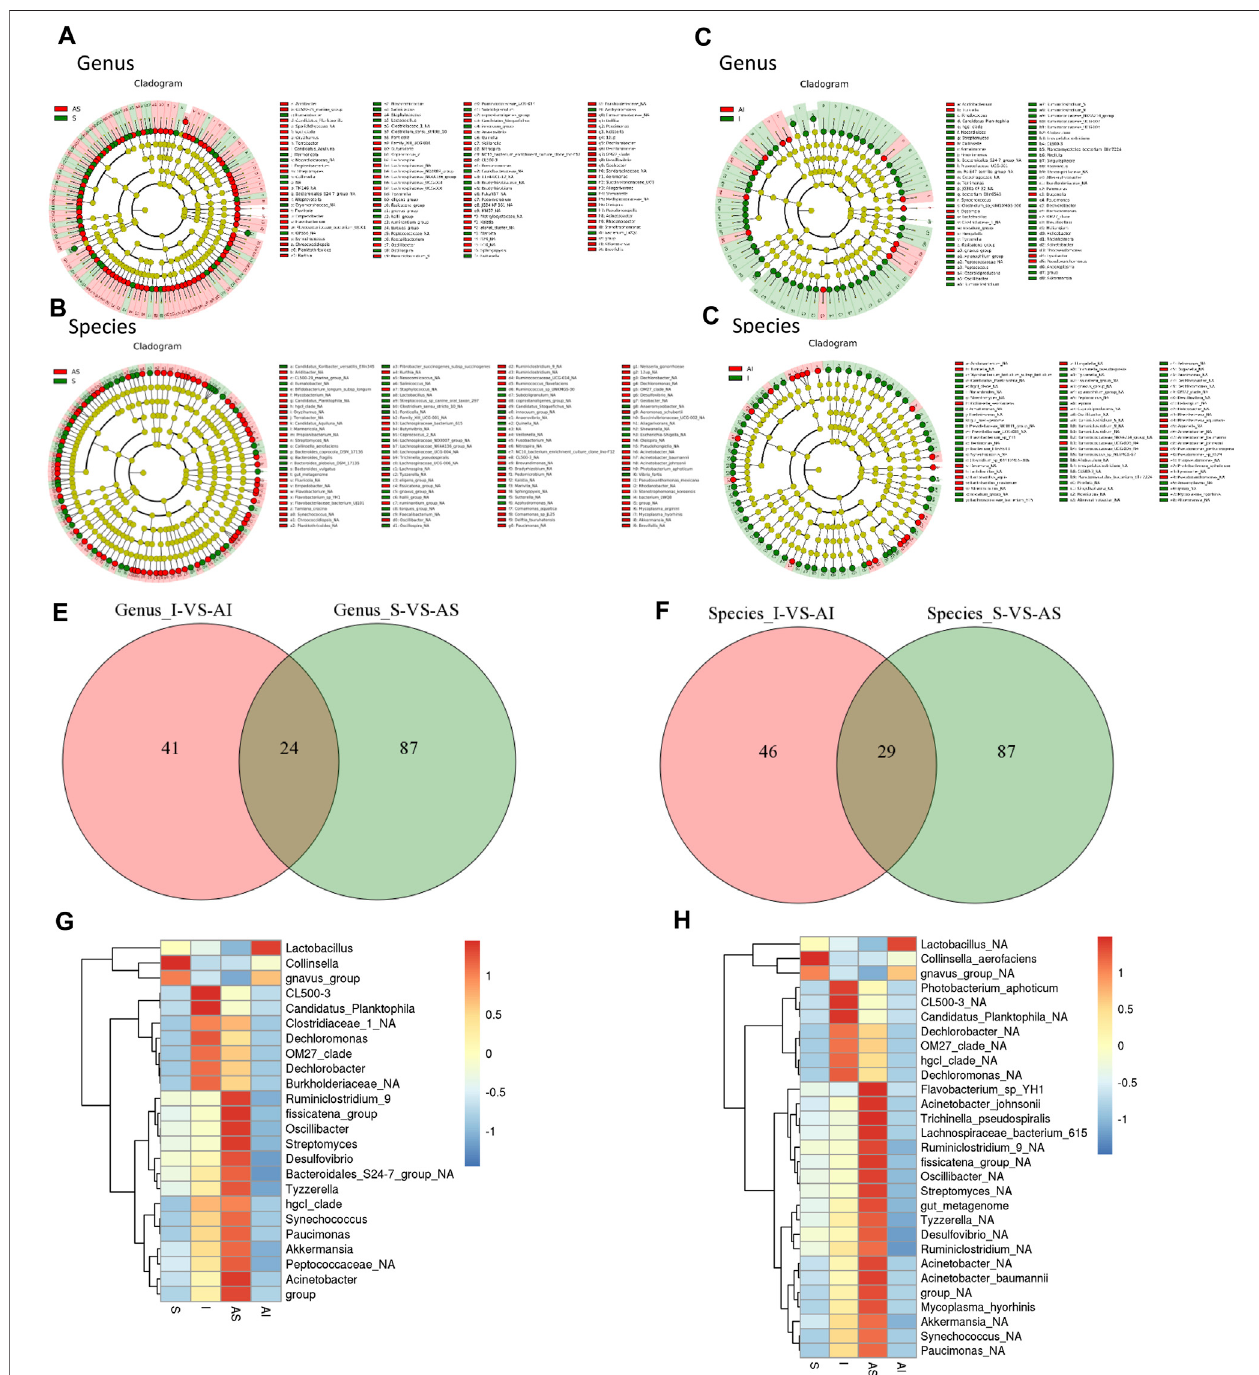
FIGURE 4 | Identi fi cation and comparison of the differential bacteria in the lung microbiota from the four groups. The cladograms at both genus and species levels for target differential bacteria between groups S and AS (A,B) , and between groups I and AI (C,D) . Venn diagrams of shared Operational Taxonomic Units (OTUs) betweengroupIandgroupAI,andbetweengroupSandgroupASatbothgenusandspecieslevels (E,F) .Heatmapsofbothgenusandspecieslevelsofdifferentiallung microbiota in the different groups (G,H) . S: sham; AS: ARB + sham; I: injury; AI: ARB + injury.